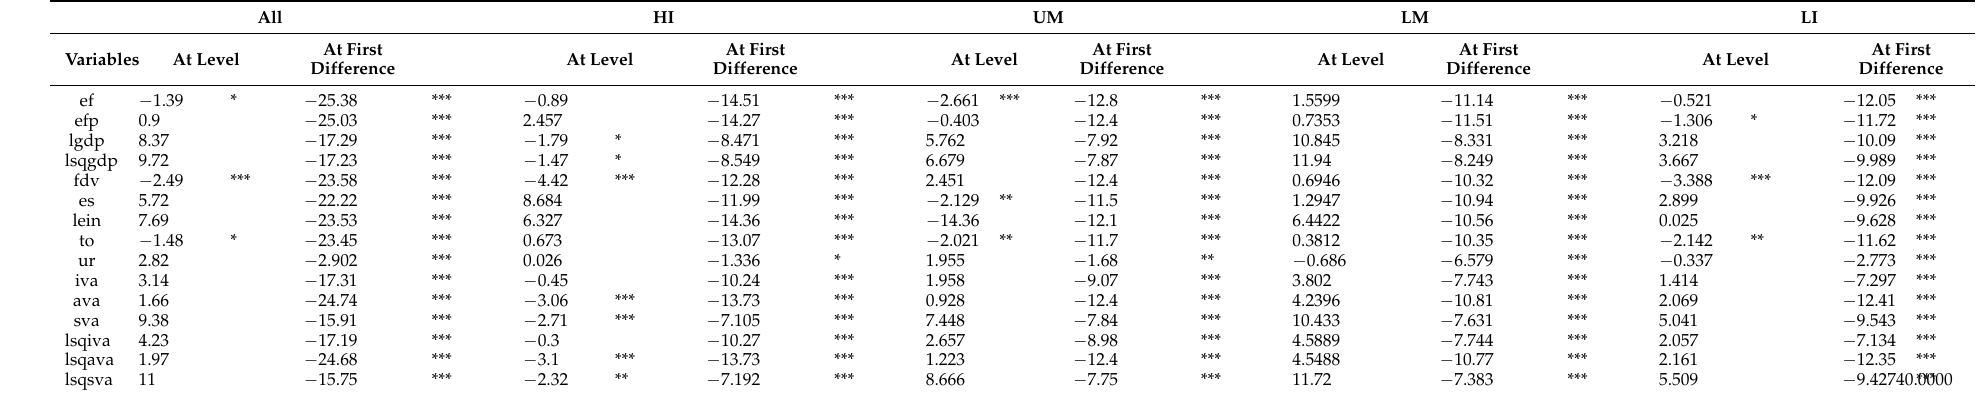
Table 3. Im–Pesaran–Shin unit-root test.